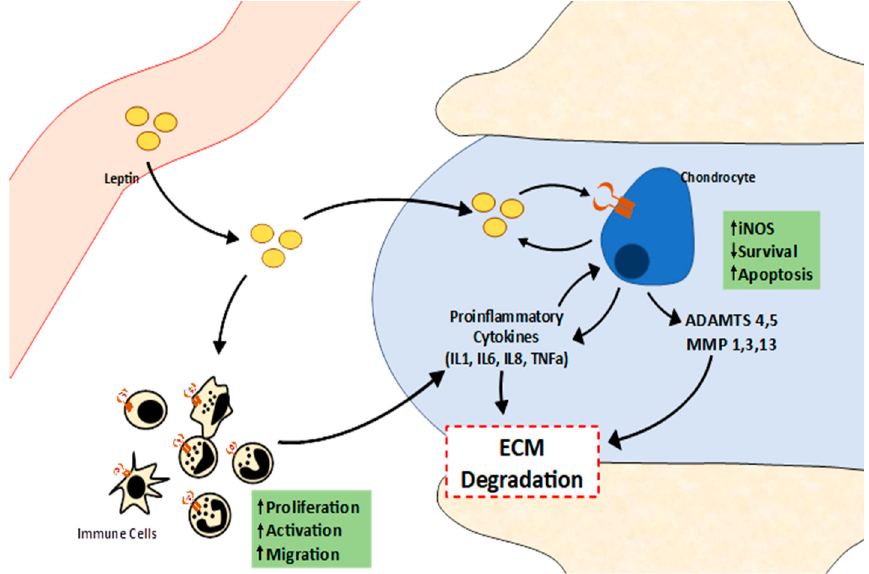
Figure 3. Schematic representation of leptin signalling in cartilage. The leptin from blood can get into the synovial cavity, where it decreases chondrocyte survival and induces apoptosis, and elevates NO production, and IL6 and IL8 secretion by chondrocytes. This activity combined with metalloproteinases (MMP) secretion by chondrocytes induces extracellular matrix (ECM) degradation. Leptin also can activate immune cells and induce its proliferation and migration to articulation, inducing pro-inflammatory activity in the tissue that contributes to ECM degradation.